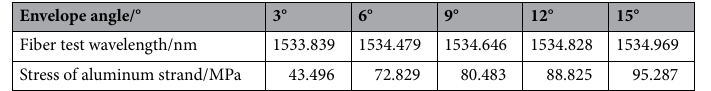
Table 9. Stress value test of aluminum strand under tension load of 0kN.